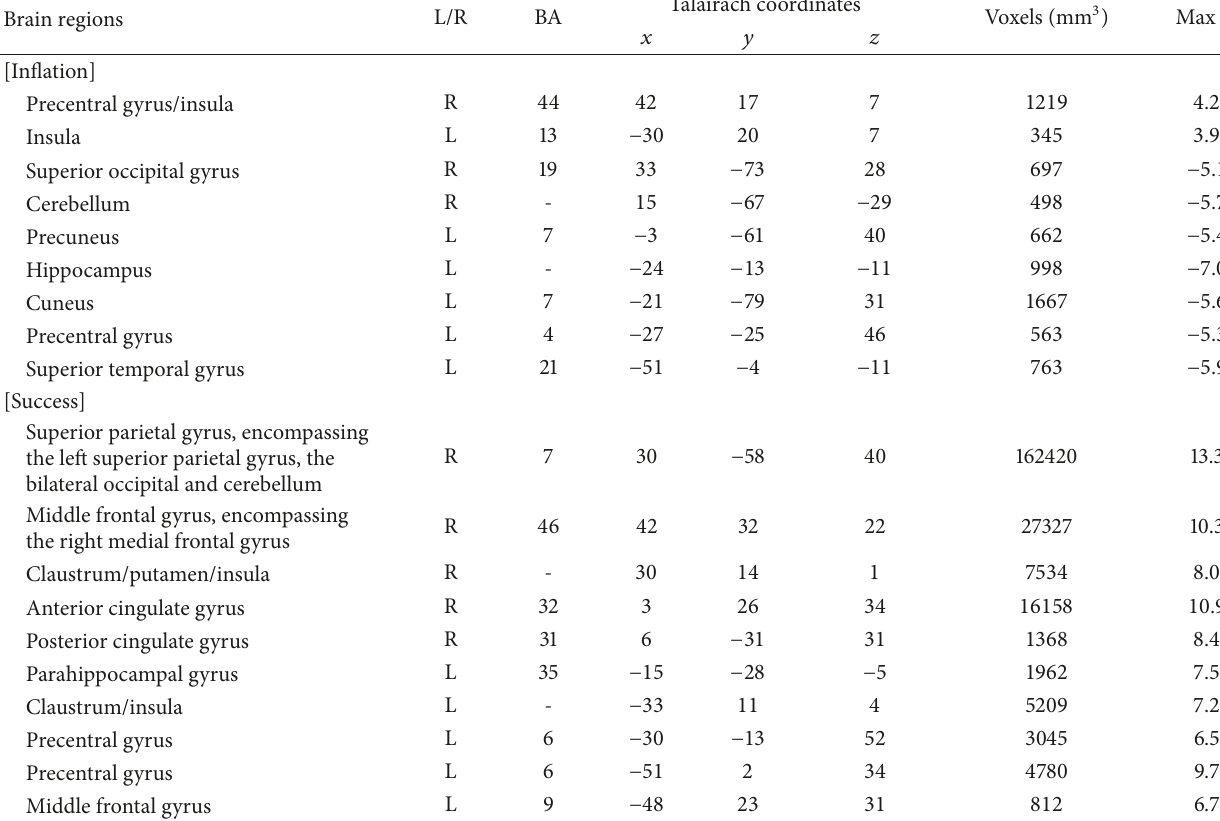
Table 2: Activations in healthy subjects during the parametrically modulated Inflation and Success